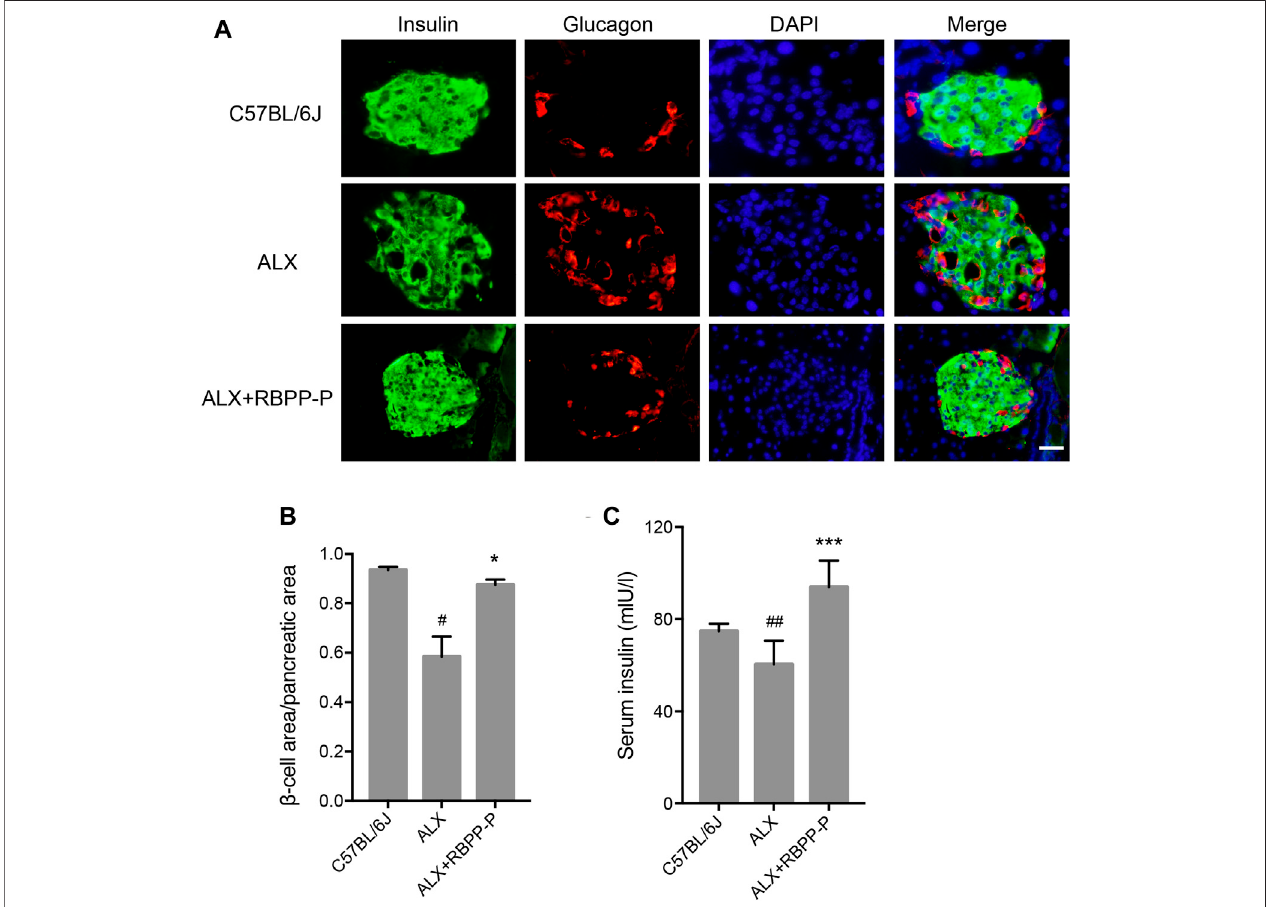
FIGURE4 | Effectsof theRBPP-Pon islet histology. (A) Immuno fl uorescence (IF) stainingfor insulin (green) and glucagon(red). Scale bar, 100 μ m. (B) β -cell area/ pancreaticarearatio,measuredbyimmuno fl uorescence staining( n (cid:1) 5). (C) Insulin levelsinserum ( n (cid:1) 10).Alldataareexpressed asmean ± s.d. # p < 0.05,vs. C57BL/ 6J mice; *p < 0.05, vs. ALX